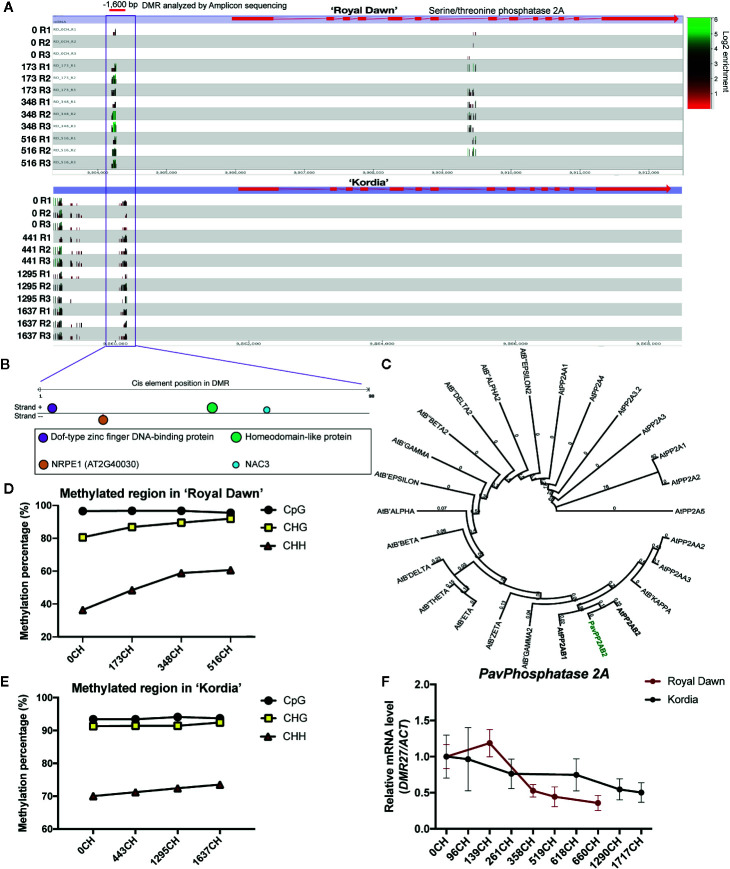
Analysis of a DMR located −1,600 bp from a PHOSPHATASE 2A (PP2AB2) gene. (A) Seqmonk genome browser of the putative PHOSPHATASE 2A (Pav_sc0004290.1_g070.1.mk) and its level of DNA methylation including all cytosine context. Methylation levels are observed as log2 enrichment in ‘Royal Dawn’ and ‘Kordia’, where green represents high levels and red, low levels. The red line indicates the DMR analyzed by Amplicon bisulfite sequencing (ABS). (B)
In silico analysis of the DMR sequence in The Plant ChIP-seq Database (PCBase), where color circles indicate the interaction sites with a zinc finger protein (AT1G64620), a homeodomain protein (AT2G40260), NRPE1 (AT2G40030) and NAC3 (AT3G15500). (C) Phylogenetic tree considering the aminoacidic sequence of PP2AB2 from sweet cherry (in bold-green) and 25 phosphatases from Arabidopsis thaliana.
(D) Level of DNA methylation as percentage in the DMR analyzed by ABS in ‘Royal Dawn’ and (E) ‘Kordia’. (F) Transcript levels of PHOSPHATASE 2A analyzed by qPCR relative to Pavβ-ACTIN using three biological and three technical replicates. Error bars represent standard deviation (SD).